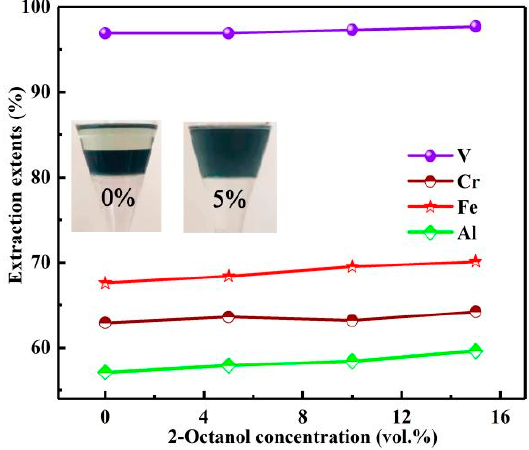
Figure 11. Influence of 2-octanol concentration on extraction extents.